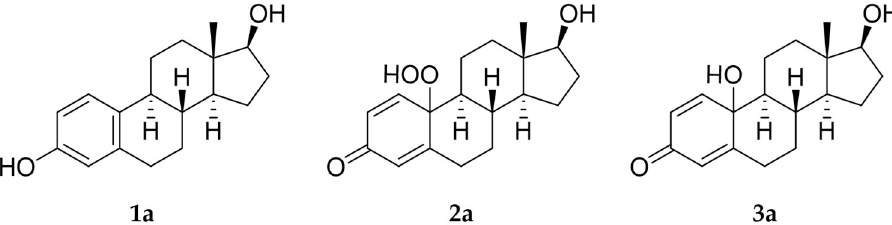
Figure 1. Structures of 17β-estradiol 1a , hydro-peroxide 2a and 10β, 17β-dihydroxyestra-1,4-dien-3- one (DHED) 3a .